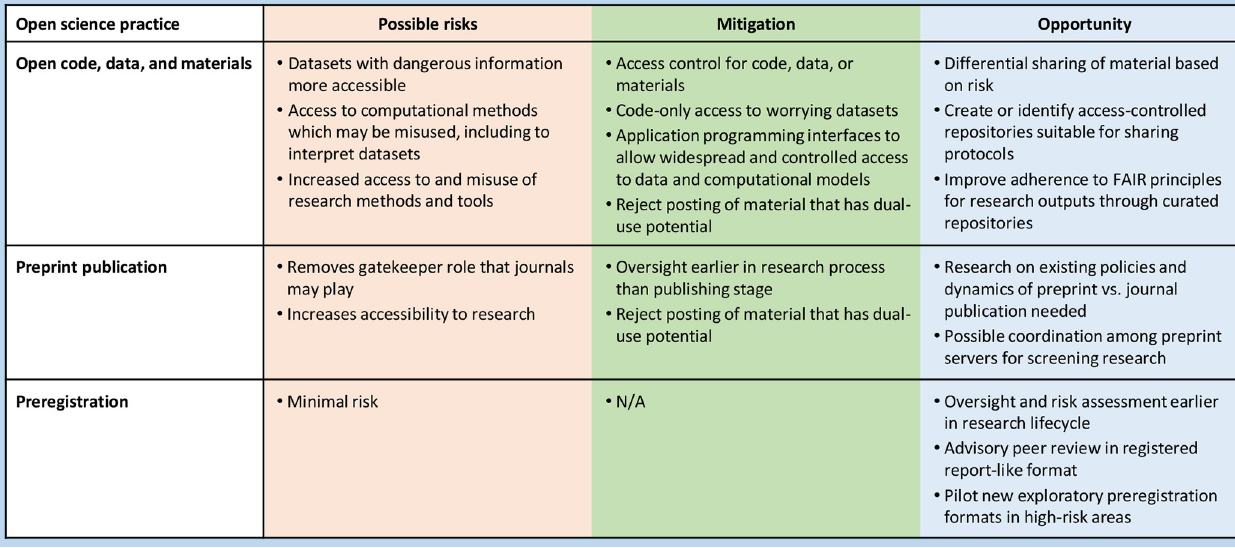
Fig 1. Summary of risks arising from open science practices, strategies to mitigate these risks, and opportunities to improve biosecurity and biosafety.